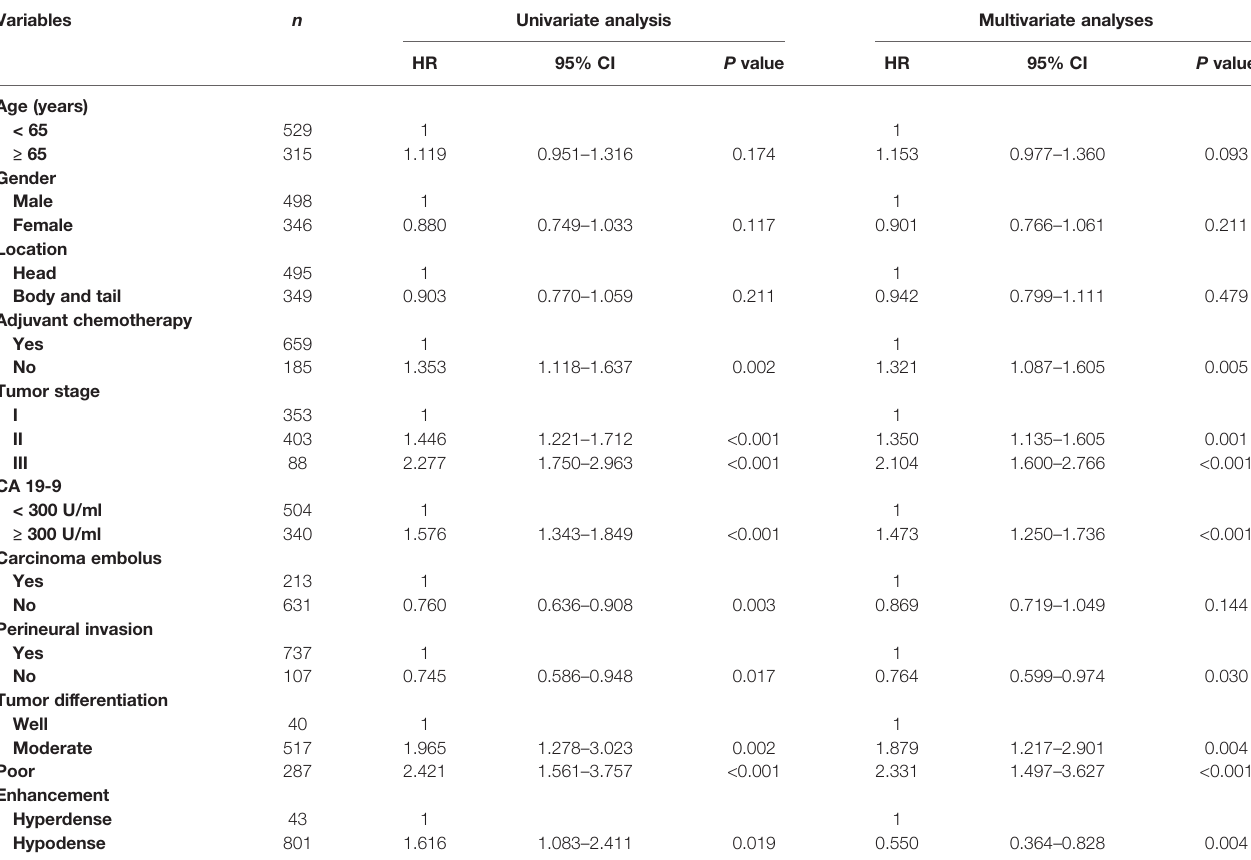
TABLE 2 | Univariate and multivariate analyses for the